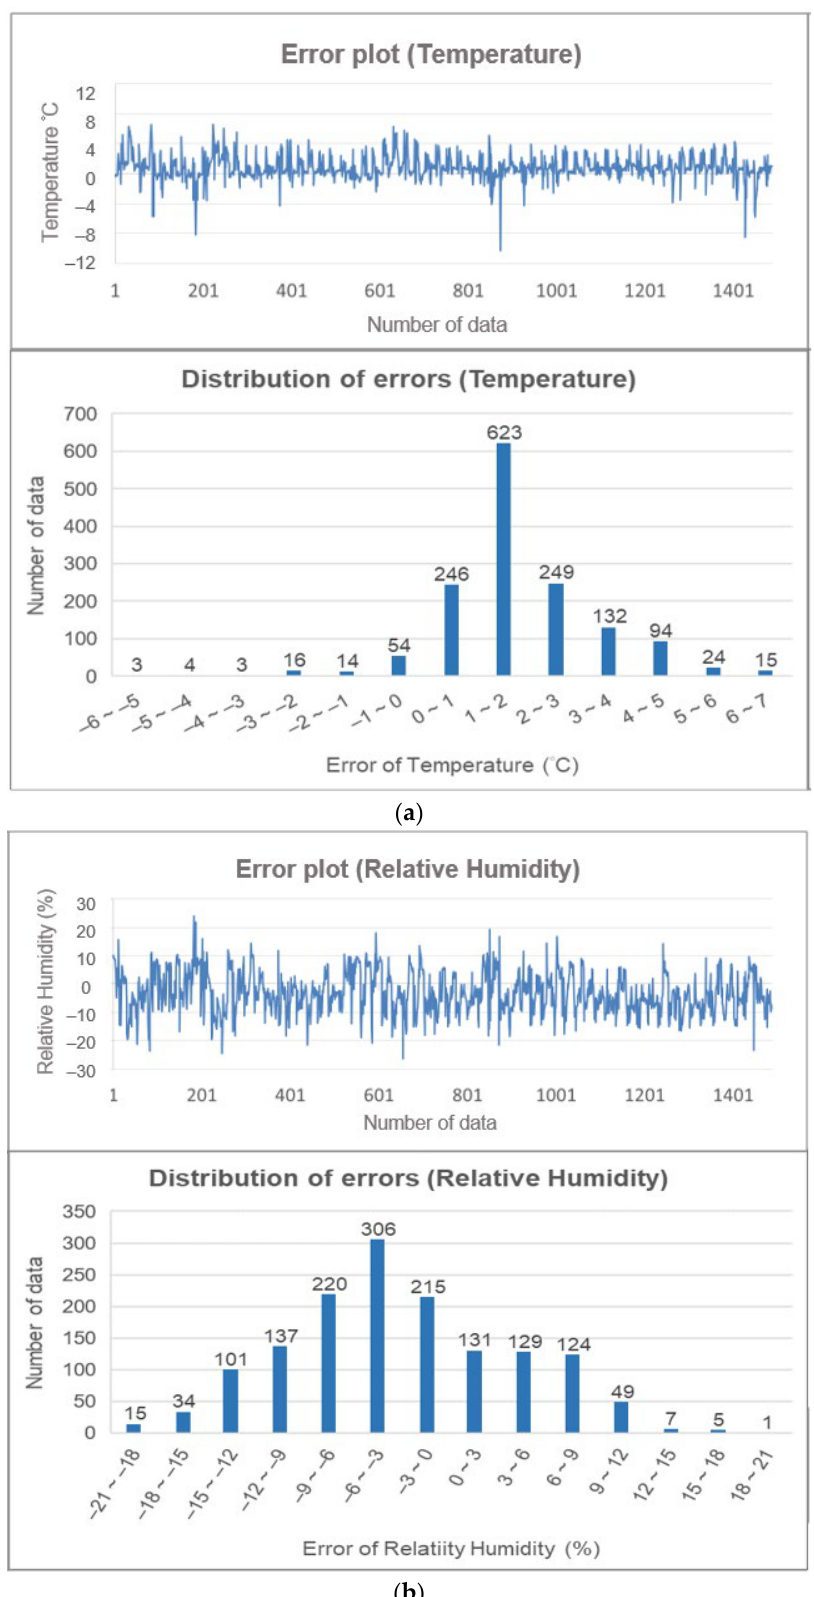
Figure 5. Errors and error distributions of greenhouse microclimate estimates from the physically based model (20 May 2019–20 July 2019). ( a ). Internal temperature. ( b ). Internal relative humidity.